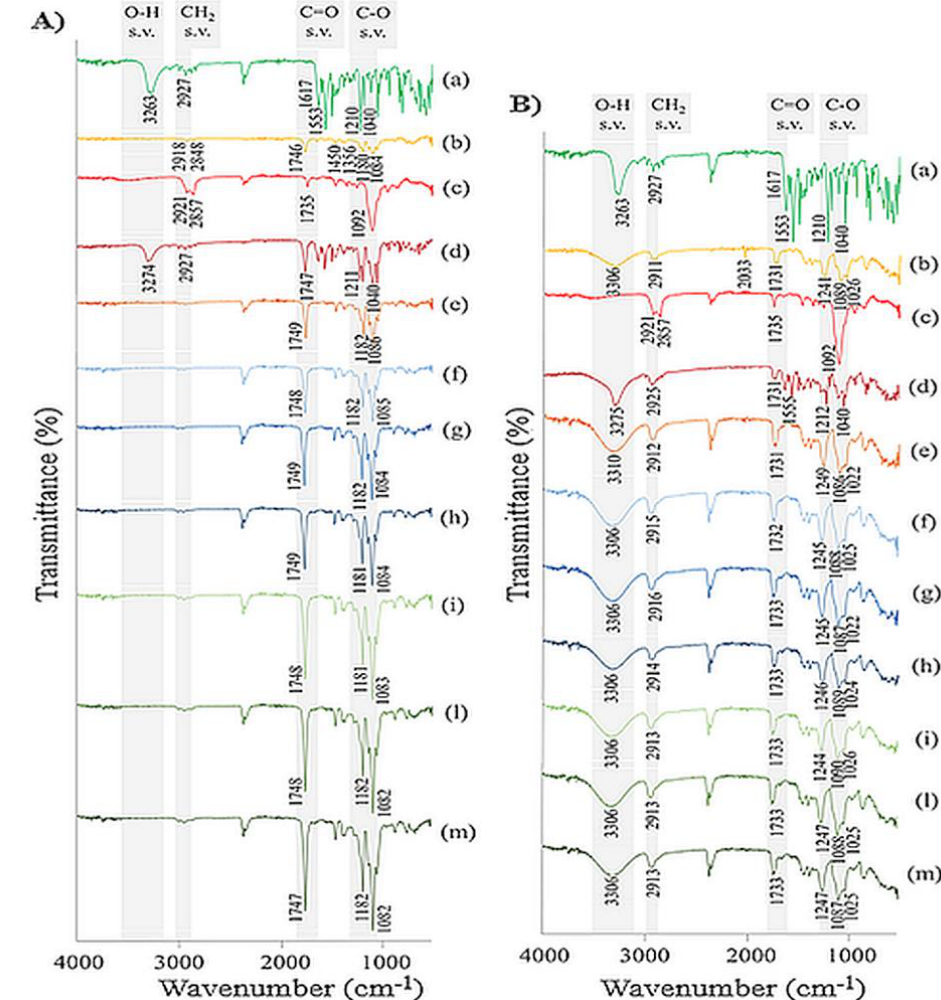
Figure 6. FT-IR curves of ( A ) Melatonin (a), PLA polymer (b), Tween ® 80 (c), physical mixture MEL+PLA polymer (d), empty-PLA nanofibers (e), Melatonin-loaded PLA nanofibers with different concentration of drug 0.1% w/w (f), 0.3% w/w (g), 0.5% w/w (h), and Melatonin-loaded PLA nanofibers with Tween ® 80 and different concentration of drug 0.1% w/w (i), 0.3% w/w (l), 0.5% w/w (m); and ( B ) Melatonin (a), PVA polymer (b), Tween ® 80 (c), physical mixture MEL+PVA polymer (d), empty-PVA nanofibers (e), Melatonin-loaded PVA nanofibers with different concentration of drug 0.1% w/w (f), 0.3% w/w (g), 0.5% w/w (h), and Melatonin-loaded PVA nanofibers with Tween ® 80 and different concentration of drug 0.1% w/w (i), 0.3% w/w (l), 0.5% w/w (m).